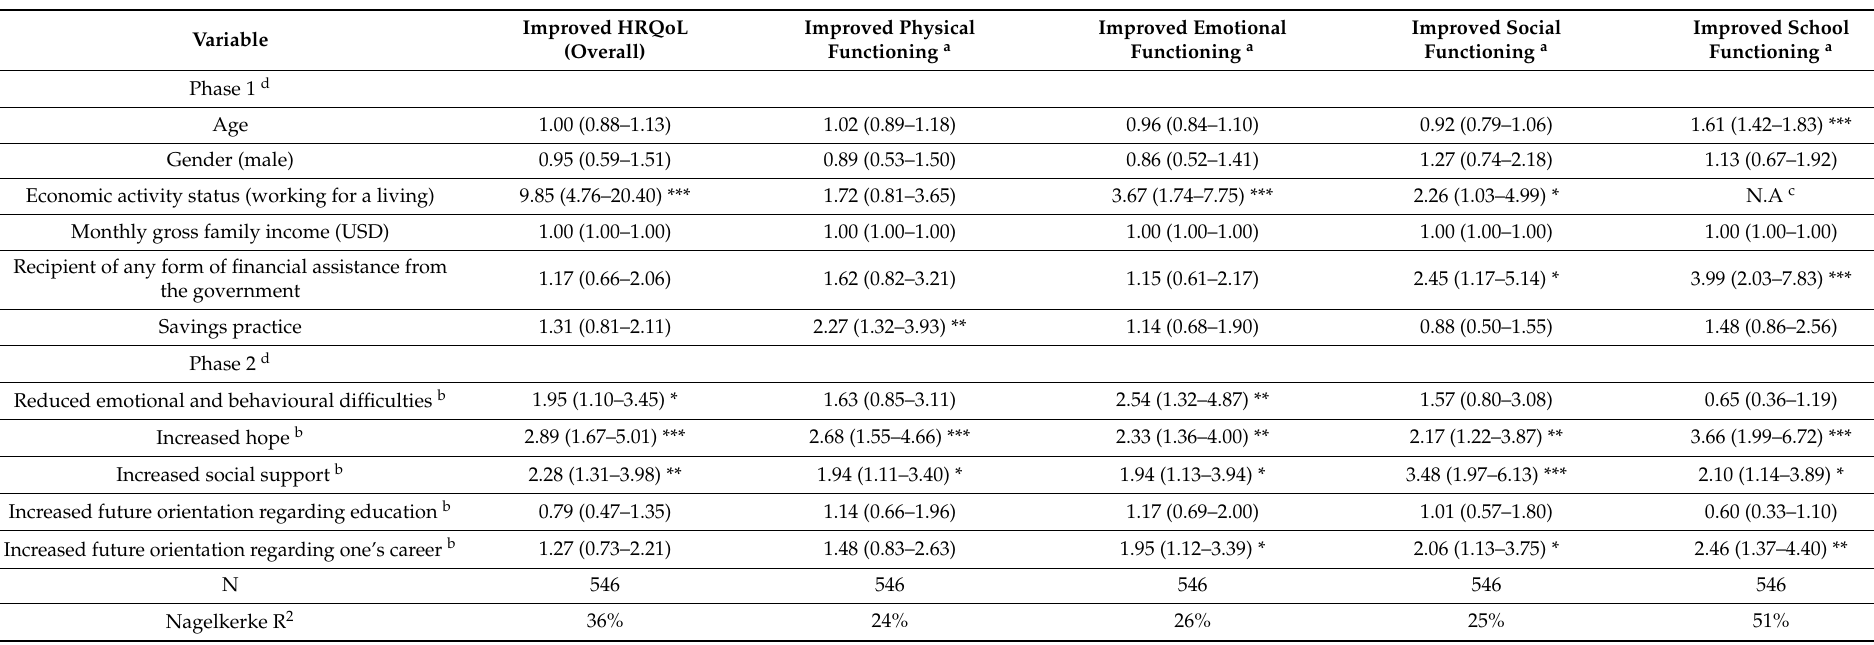
Table 2. Adjusted odds ratios (and 95% confidence intervals) of the two-stage logistic regression analyses using improvements in health-related quality of life as